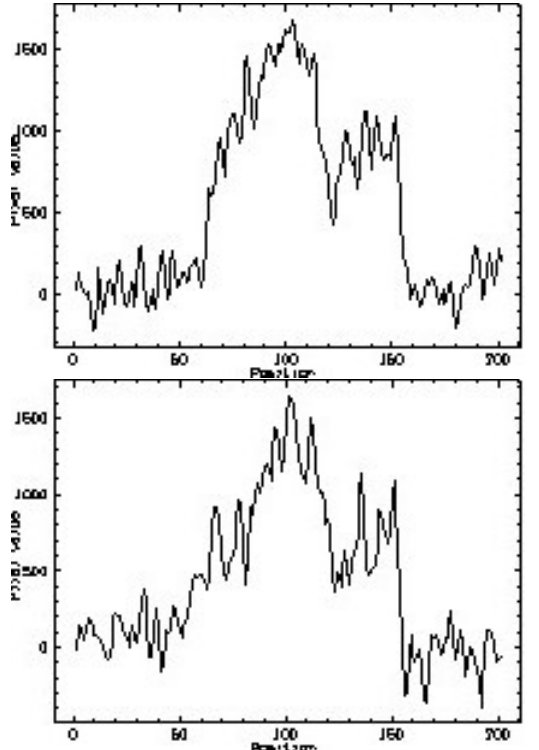
Figure 5. DFBS low-dispersion spectra for two genuine WDs (PG 0109+111 and PG 1449+168) showing the shape of their